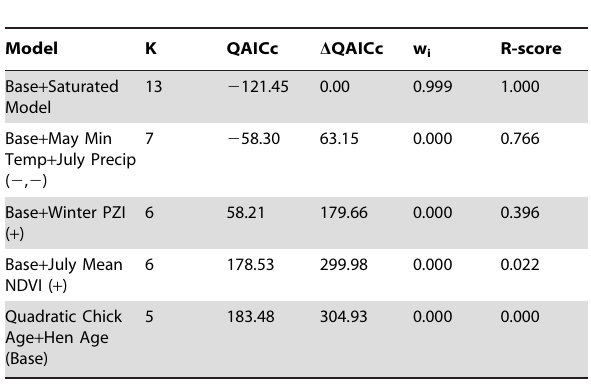
Table 2. Comparison of top chick survival models among the landscape-scale covariate